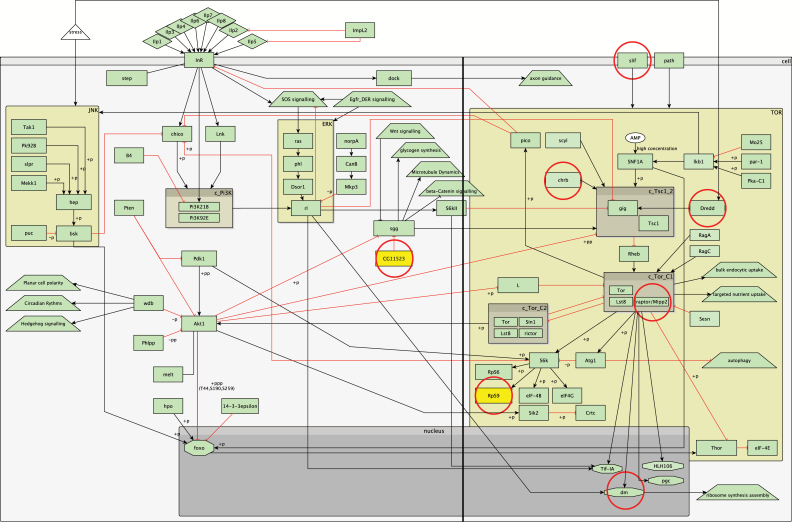
Overview of the insulin/insulin-like growth factor signaling (IIS) and target of rapamycin pathway (TOR) pathways. Rectangles represent genes; diamonds: molecules; triangles: environmental factors; trapezoids: other than IIS or TOR pathways; octagons: transcription factors; arrow lines represent activation; red t-shaped lines represent inhibition; brown boxes starting with c_ represent complexes; yellow boxes represent putative genes part of the IIS (CG11523) or TOR (RpS9) pathways; genes circled in red represent genes found in the top-ranked genes in the gene-based analysis; black horizontal line represents a symbolic separation between the TOR and IIS pathways.